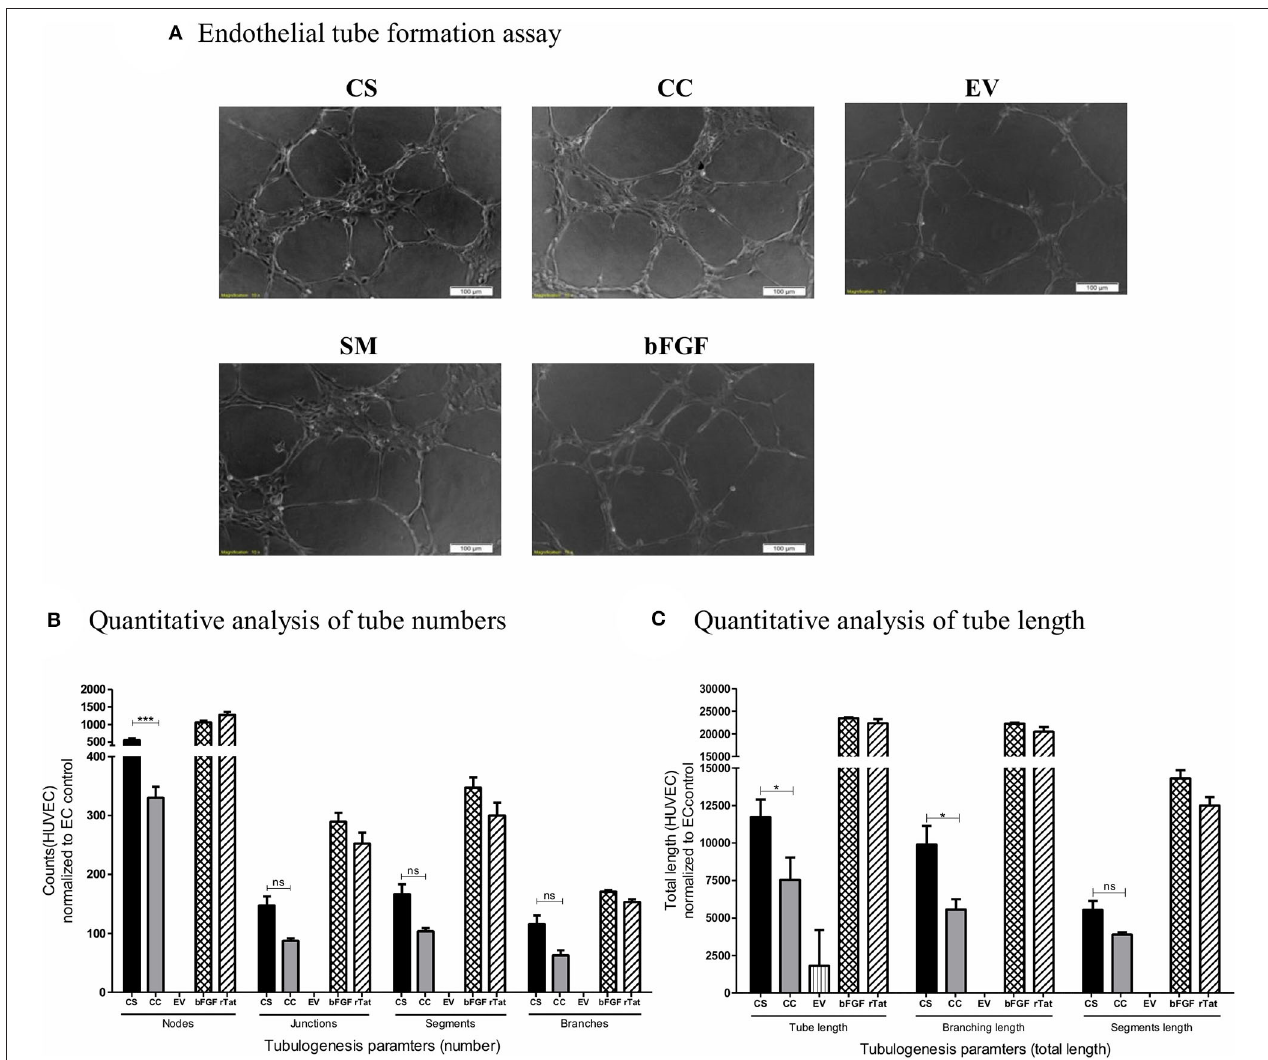
FIGURE 4 | Tube formation of HUVEC following treatment with conditioned media. Conditioned media from Jurkat-Tat cells were harvested following 12h of Dox-induction. 20,000 HUVEC in respective conditioned media were seeded over Matrigel in a 96-well plate. The HUVECs seeded in RPMI supplemented with 10% FBS served as the endothelial cell (SM) background control, and HUVECs treated with bFGF (2ng/ml) and rTat (1 ng/ml) served as positive controls in the assay. (A) The cells were imaged at 2h intervals for the tube formation, and the images captured at 4h using a 10 × objective are presented. The images were quantified using the Angiogenesis Analyzer plugin for ImageJ (NIH). The images were transformed to skeletonized binary tree form and analyzed for the tube parameters. The individual values were normalized to the SM control values for each parameter. (B) The normalized counts for the number of nodes, junctions, segments, and branches for CS, CC, EV, and bFGF treated HUVECs. (C) The total length, branching length, and segment length following different treatments. The counts and lengths ± SD are plotted, and the data are representative of three independent experiments. Two-way ANOVA with Bonferroni post-test (* p < 0.05, *** p < 0.001 and ns,